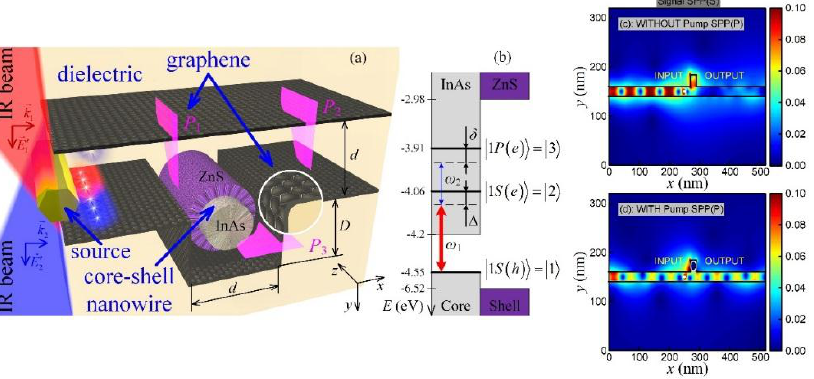
Fig. 1. (a) The model of plasmonic waveguide integrated with stub nanoresonator based on the pair of graphene sheets and core-shell NW; (b) the Ladder-type interaction scheme of two SPP modes and InAs/ZnS NW. The summarized electric field distribution of signal SPP in the device (c) without pump SPP and (d) with pump SPP. The black lines correspond to the graphene waveguide with stub nanoresonator and circled white line depicts the